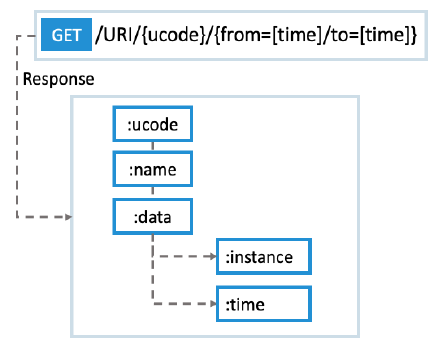
Figure 3. The unified API